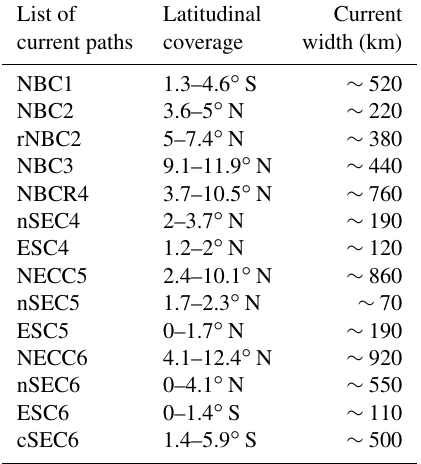
Table 1. Extension in latitude and kilometers for the different cur- rent branches crossing the different horizontal sections: NBC1, NBC2, and NBC3 are the North Brazil Current captured along HS1, HS2, and HS3, respectively; NECC5 and NECC6 are the North Equatorial Countercurrent captured along HS5 and HS6, respec- tively; nSEC4, nSEC5, and nSEC6 are the northern branch of the South Equatorial Current (SEC) captured along HS4, HS5 and HS6, respectively; cSEC6 is the central branch of the SEC captured along HS6; and ESC4, ESC5, and ESC6 are the Eastward Equatorial Sur- face Current captured along HS4, HS5, and HS6,